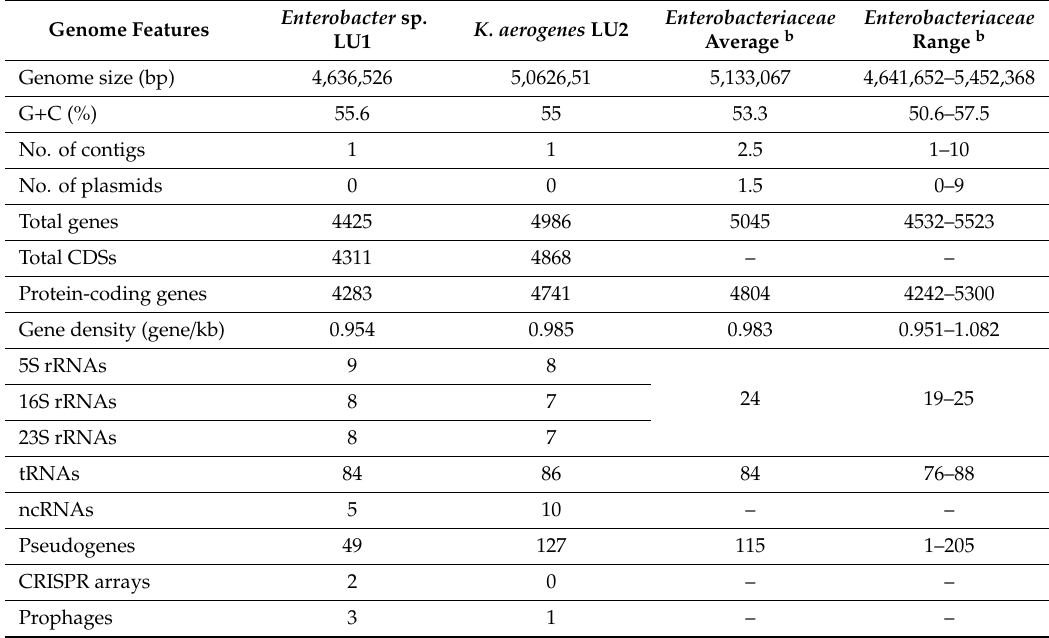
Table 2. General features of Enterobacter sp. LU1 genome compared to K. aerogenes LU2 (formerly E. aerogenes ) genome and 15 complete Enterobacteriaceae genomes a